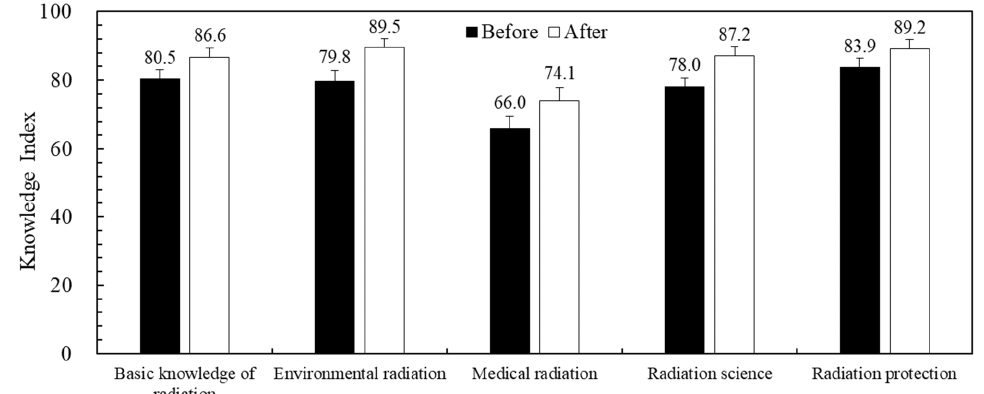
Figure 2. The knowledge index of the students before/after the radiation education